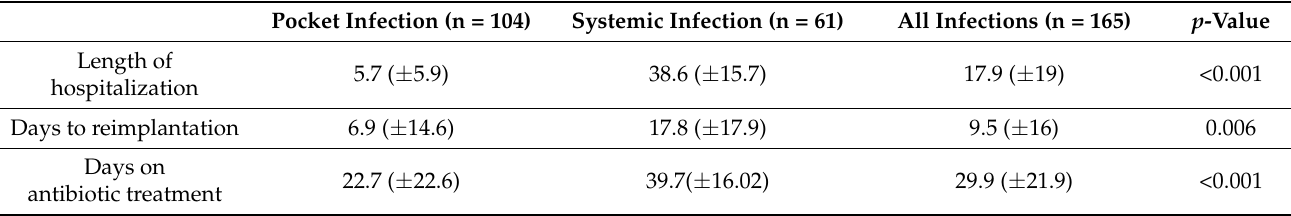
Table 3. Length of hospitalization, days of antibiotics treatment, and days until re-implantation in 165 patients with CIED